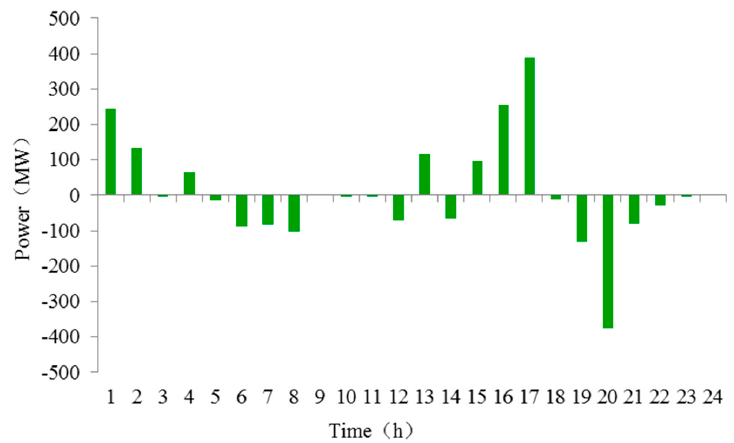
Figure 15. Power output curves of pumped storage in Case 2. Energies 2018 , 11 , x FOR PEER REVIEW